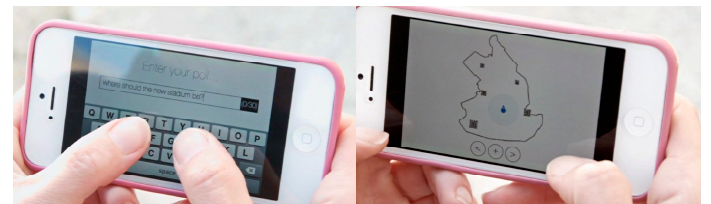
Figure 9. The app [Y]our Perspective. A person launches a poll about the advisability of building the new stadium in the historical centre of the city ( left ); Another person receives the poll when walking in the area ( right ).